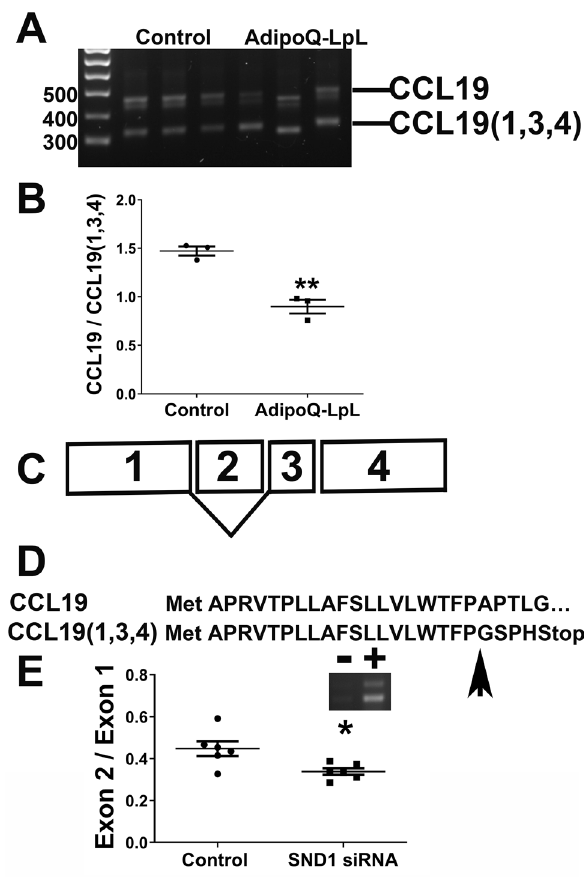
Figure 7. SND1 regulates Ccl19 splicing. ( A ) RNA from the adipose tissue of control or AdipoQ-LPL mice was subjected to PCR with primers located in exon 1 and 4 of Ccl19 . The PCR products were resolved on an agarose gel and then sequenced. The positions of full-length Ccl19 and the shorter isoform, which was found to lack exon 2 by DNA sequencing, are indicated. ( B ) The ratio of full-length Ccl19 to Ccl19 (1,3,4) was calculated. The data are represented as the mean ± SEM (n = 3; **P < 0.01; two-tailed unpaired Student’s t-test). ( C ) A diagram showing the four exons of Ccl19 and alternative usage of exon 2. ( D ) Translation of the full-length and Ccl19 (1,3,4) reveals that when exon 2 is missing, the reading frame shifts and a premature stop codon is present. The arrow indicates the position of the amino acid affected by the frame shift. ( E ) Inset: induction of two Ccl19 isoforms in 3T3-L1 adipocytes by TNFα. The ratio of exon 2 to exon 1 in 3T3-L1 adipocytes treated with scrambled or Snd1 siRNA and the TNFα were calculated by real time RT-PCR with exon specific primers and Ccl19 plasmid DNA to construct the standard curve. The data are represented as the mean ± SEM (n = 6; *P < 0.05; two-tailed unpaired Student’s